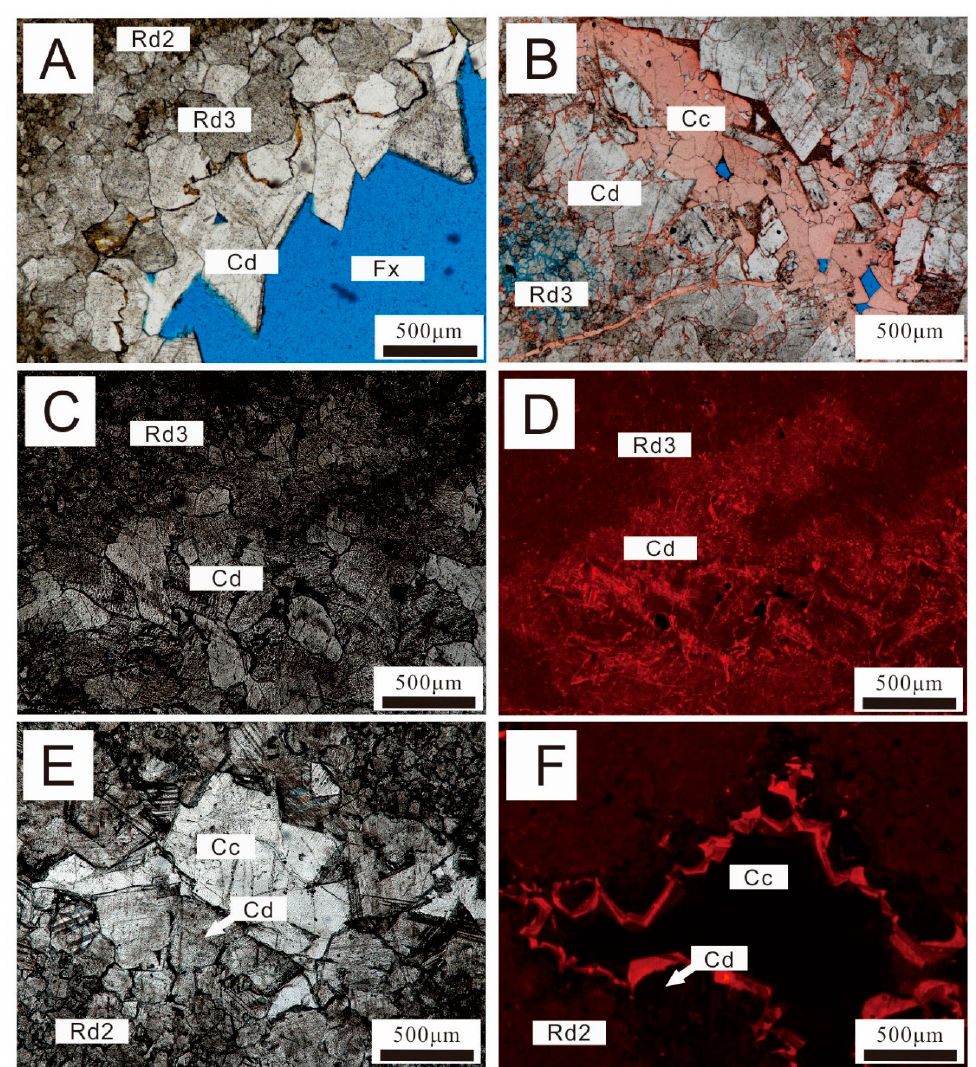
Figure 7. Cd dolomite. ( A ) Photomicrograph showing Cd dolomite filling in the hydraulic fractures (Fx), close to the matrix Rd3 dolomite and fine crystal dolomite (Rd2); ( B ) photomicrograph of void-filling Cd dolomite coarse-textured crystal aggregates and the residual porosity filled by later calcite (Cc) (Frac./Vug Cal) (Zhangcun; P 2 q ); ( C , D ) paired photomicrographs (CL) of void-filling Cd dolomite and host Rd3 dolomite. Both Rd3 dolomite and Cd dolomite show strong dull-red luminescence and Cd dolomite exhibits mottled luminescence (Zhangcun; P 2 q ); ( E , F ) paired photomicrographs (CL) of void-filling Cd dolomite, void-filling calcites, and host Rd2 dolomite. Rd2 dolomite shows dull-red luminescence and Cd dolomite shows bright-red rims with non-luminescence of calcites (Xinjigu; P 2 q ).